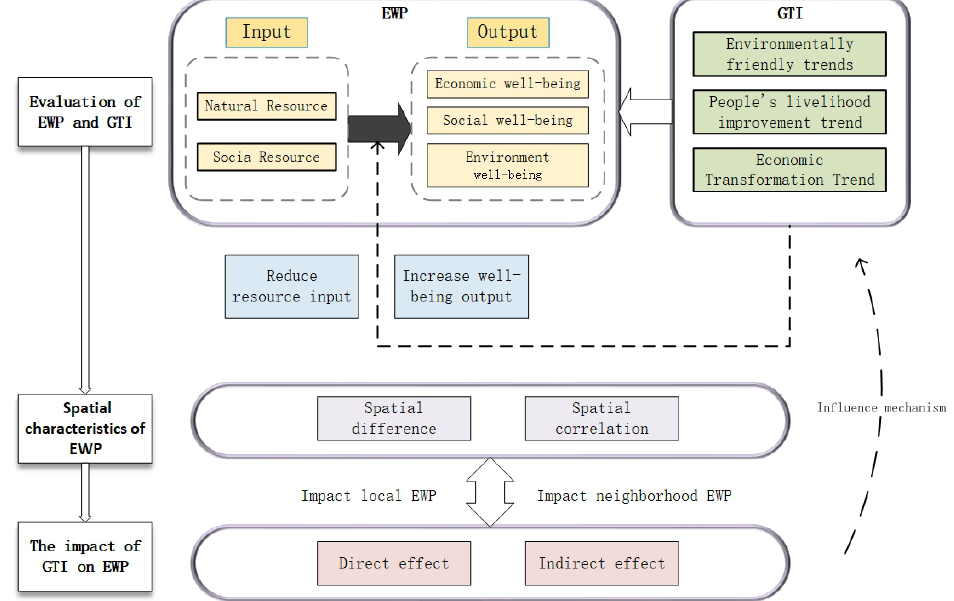
Figure 1. The research framework for the impact of green transition on ecological welfare performance.